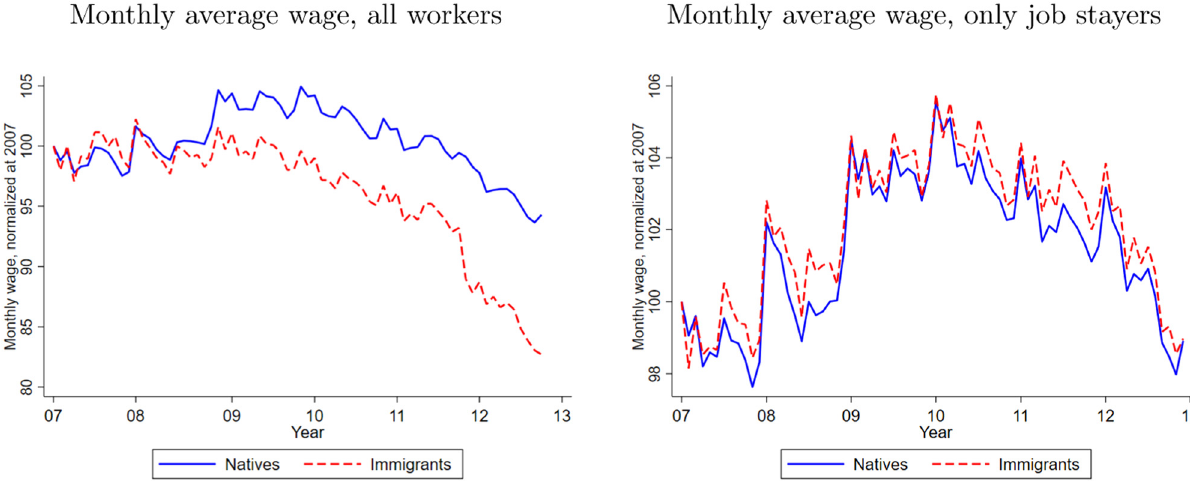
Figure A9: Normalised monthly real wage by nationality, aggregate vs job stayers ( 2007 – 2012 ) . Note: The monthly wages are normalised to 100 at January 2007. Source: MCVL.